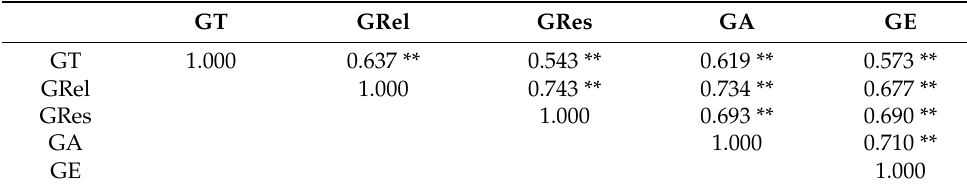
Table 7. Spearman’s Rho correlation coefficients among the gaps of perceptions-expectations of the SERVQUAL dimensions ( n =